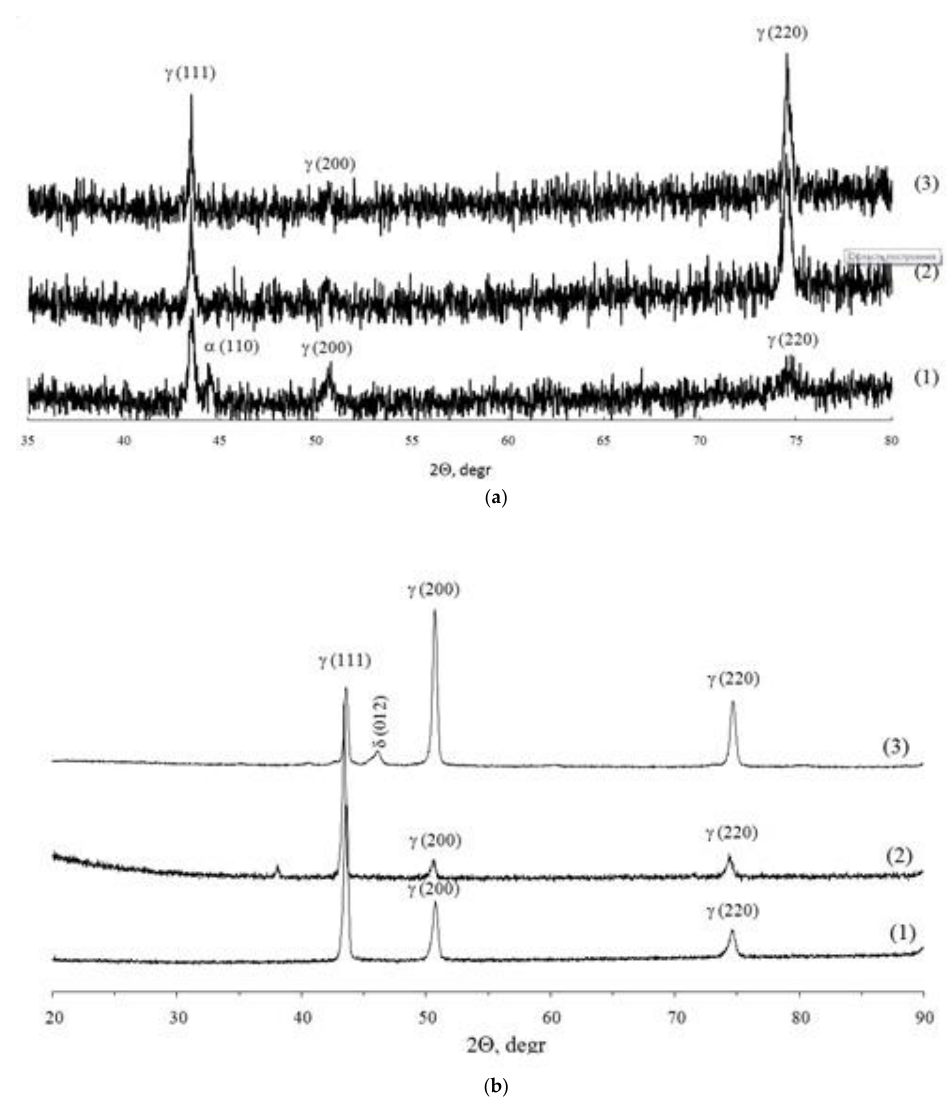
Figure 10. X-ray phase analysis results of 316L steel ( a ) and Inconel 718 alloy ( b ) specimens in various structural states: (1) powder; (2) SLM specimen; (3) SLM specimen after high-temperature testing in hydrogen.